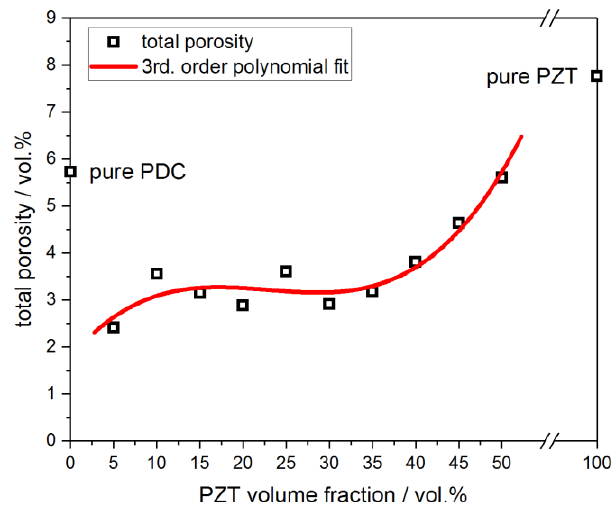
Figure 3. Porosity of the PZT-polymer composites crosslinked at 200 °C as a function of the PZT filler volume fraction.